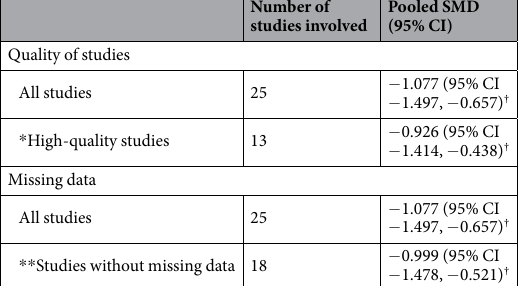
Table 4. Results of sensitivity analyses based on quality of studies and exclusion of studies with missing data. Abbreviations: SMD, standardized mean difference; CI, confidence interval. * Newcastle-Ottawa quality assessment total score ≥ 7. ** Exclusion of Ahmadi, et al . 37 , Piper, et al . 25 , Wright, et al . 34 , Barsalou, et al . 40